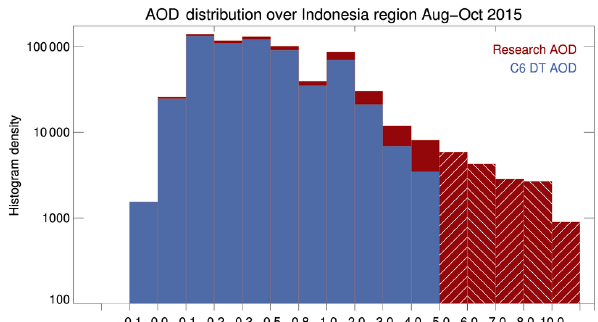
Figure 9. The histogram of MODIS AOD over the Indonesia region from August to October 2015 in a logarithmic scale. The red is the research AOD, the blue is the operational C6 AOD. Data that are greater than 5 from the research AOD are shaded using white